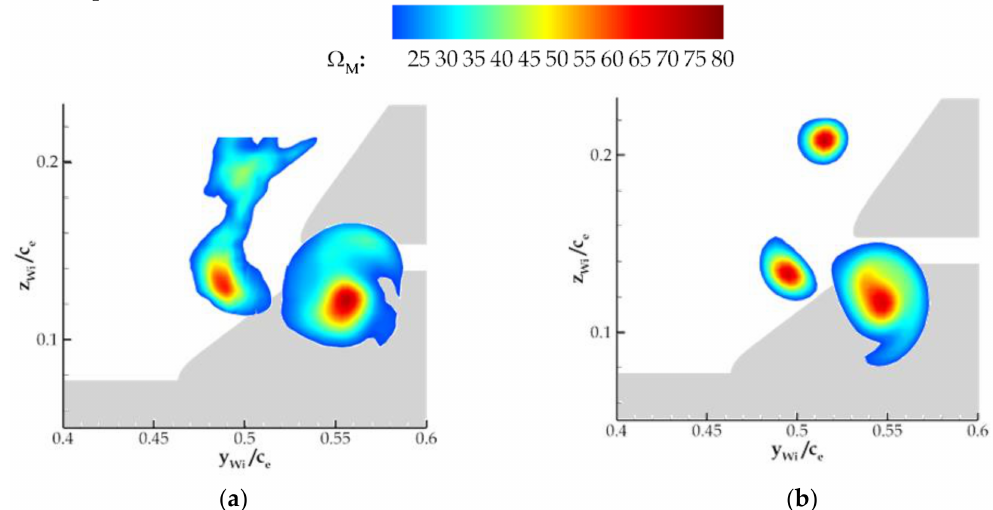
Figure 13. Contours showing a comparison of the mean vorticity magnitude of the endplate vortices at x Wi /c e = 1.056.